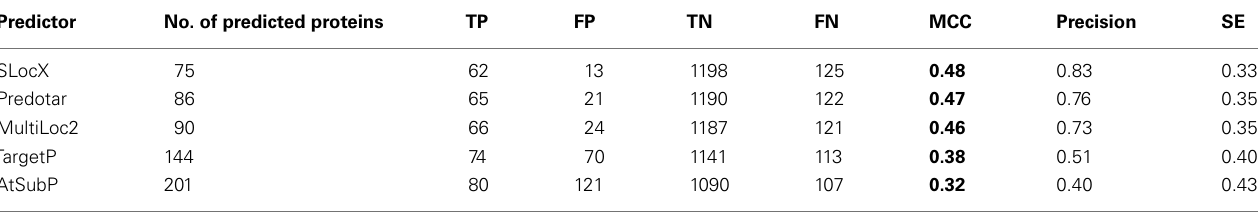
Table 4 | Benchmarking of predictions from SLocX, Predotar, MultiLoc2,TargetP, andAtSubP on the independent test set of 1,398 proteins.